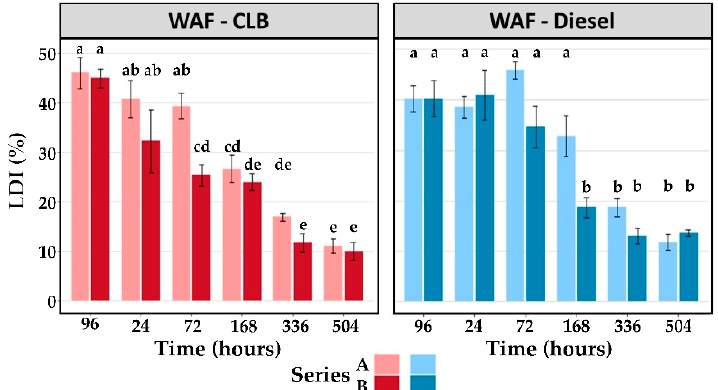
Figure 8. Fraction of lysosomal membrane destabilization (LDI) in lobster’ hemocyte cells for WAF-CLB and WAF-Diesel treatments during the recovery period in series A and B. Mean ± SE; n = 3. The letter symbols indicate a significant (p < 0.05) effect between time and series.